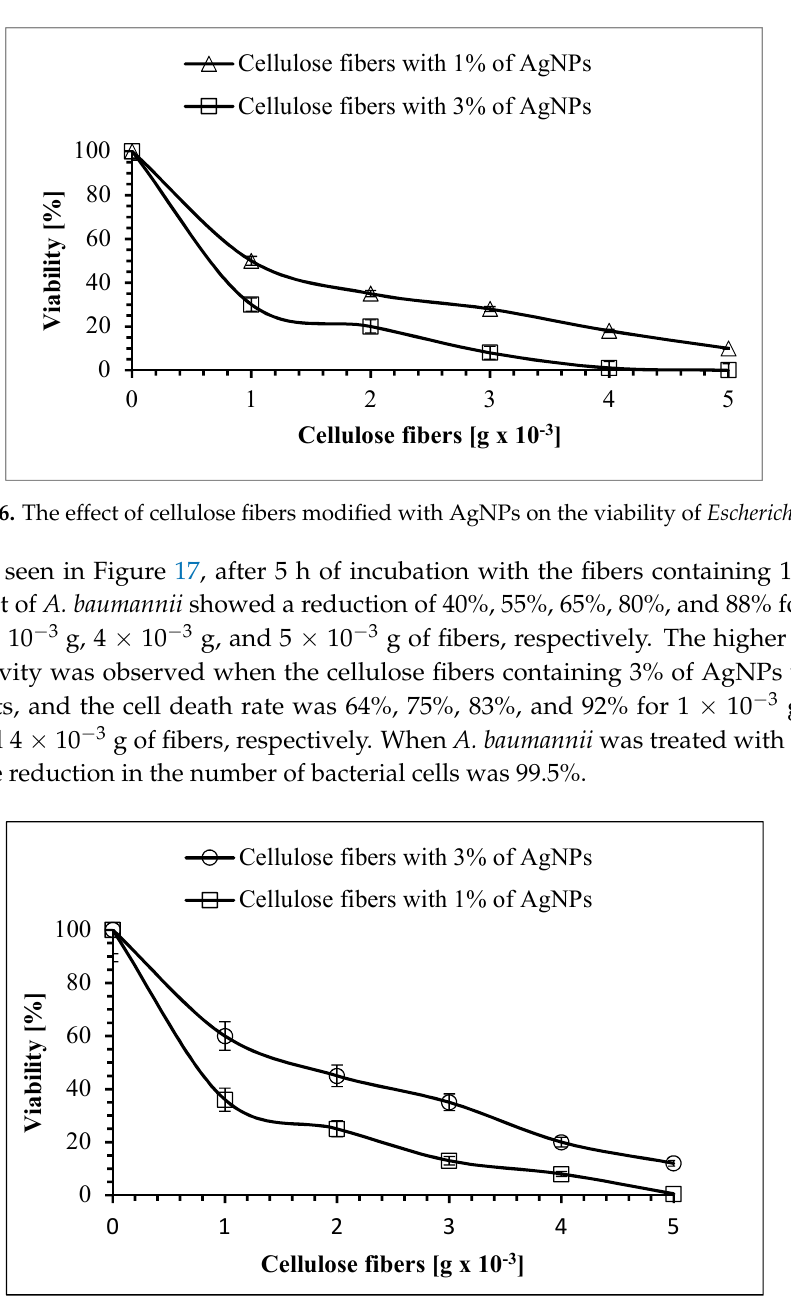
Figure 17. The effect of the cellulose fibers modified with AgNPs on the viability of Acinetobacter baumannii.